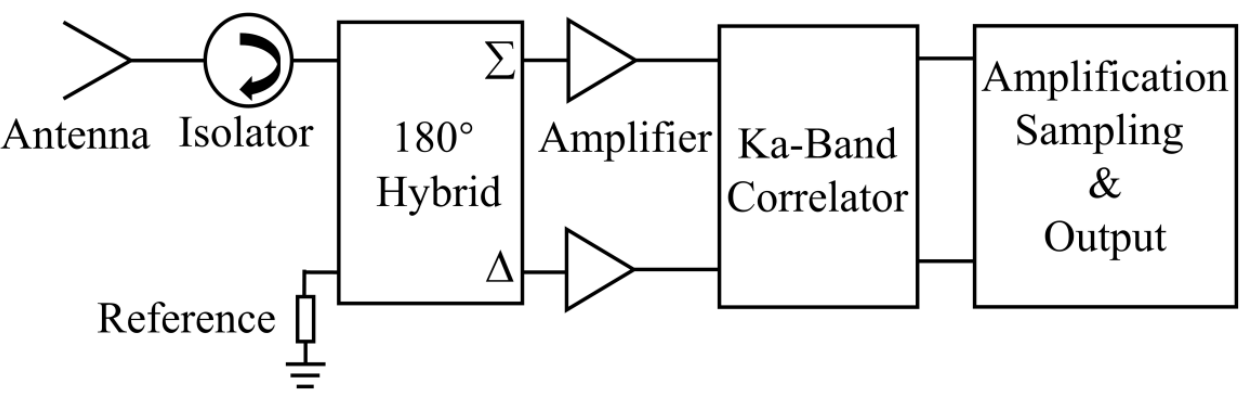
Figure 18. The final designed thermometer.